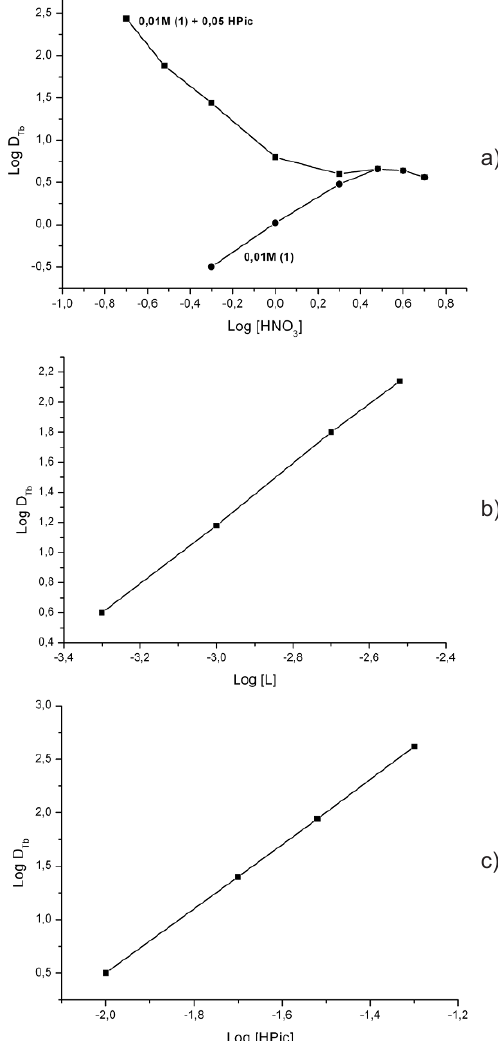
Figure 5. a) The effect of HNO concentration in the aqueous 3 phase on the extraction of Tb(III) by 0.01 M solutions of 1 in 1,2-dichloroethane and in the presence 0.05 M Hpic; b) The effect of extractant 1 concentrations in 1,2-dichloroethane on the extraction of Tb(III) solutions ([HPic] = 0.05 M); from 0.1 M HNO 3 c) The effect of HPic concentrations in 1,2-dichloroethane on the extraction of Tb(III) from 0.1 M HNO solutions 3 ([1]= 0.005